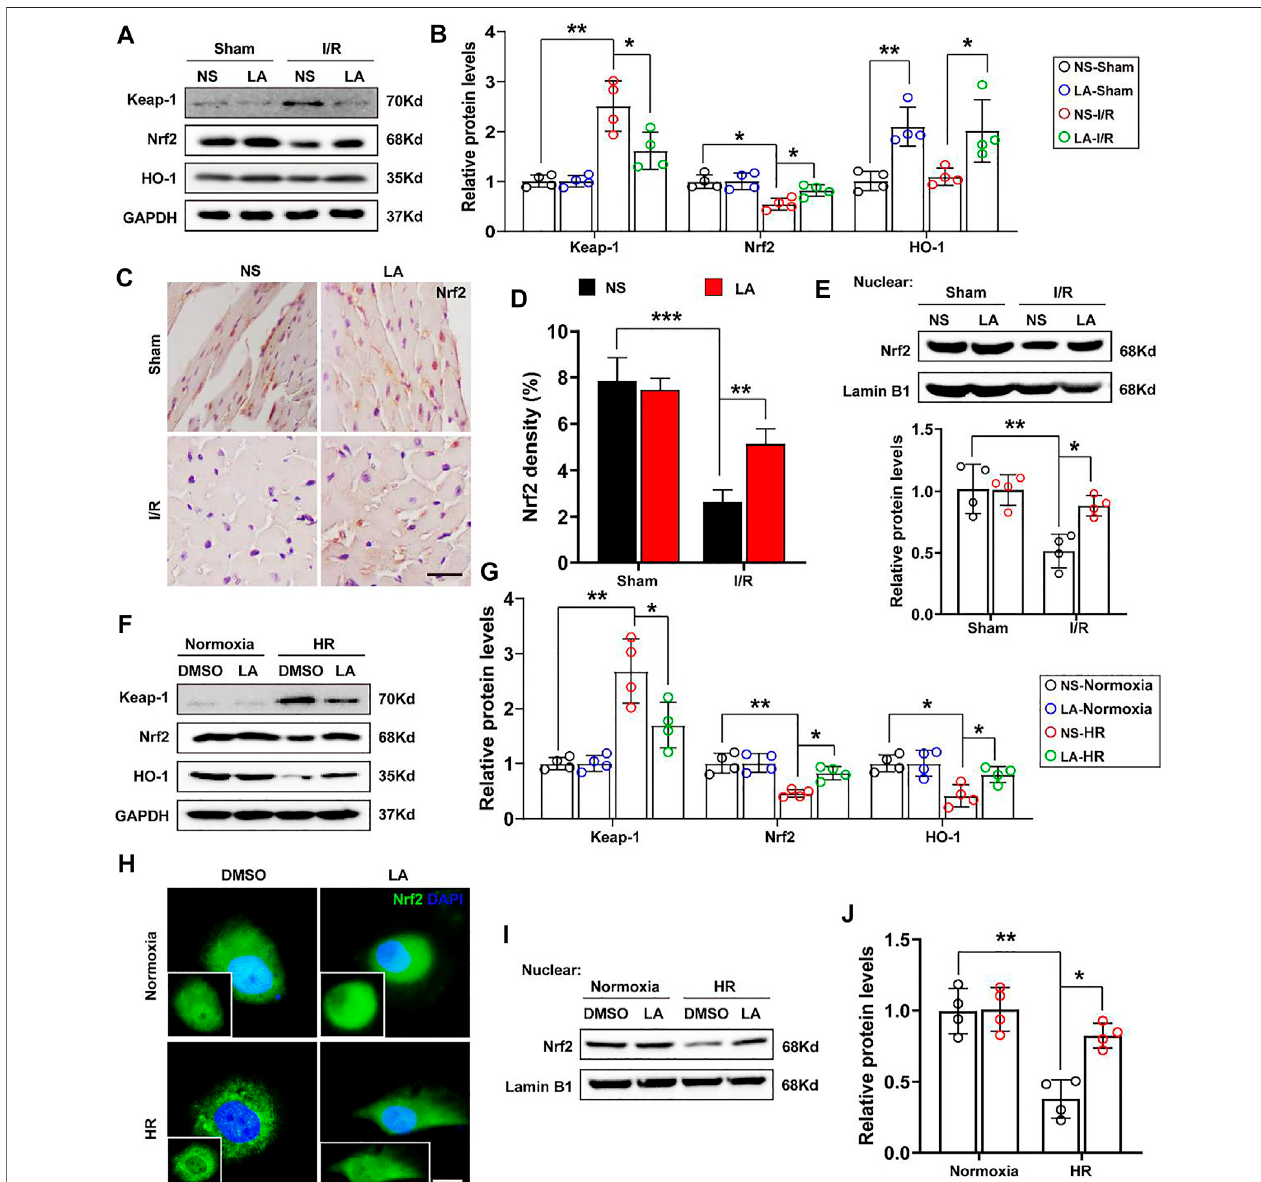
FIGURE6| LAcontributes toactivationofNrf2/HO-1pathway andnucleartranslocation ofNrf2 invivo and invitro (A,B) .Representative westernblot and analysis of Keap-1, Nrf2 and HO-1 in hearts following MI/R or sham, normalized to GAPDH ( n (cid:1) 4) (C,D) . Representative immunohistochemistry and density analysis of Nrf2 in heart tissues ( n > 25 from 3 mice per group). Scar bar: 100 μ m (E) . Representative western blot and analysis of Nrf2 in nuclear from fresh heart tissues, normalized to Lamin B1 ( n (cid:1) 4) (F,G) . Representative western blot and analysis of Keap-1, Nrf2 and HO-1 in H9C2 cells, normalized to GAPDH ( n (cid:1) 4) (H) . Representative immuno fl uorescence ofNrf2 inLA or DMSO pretreated H9C2 cells withor without HR. Scarbar: 10 μ m (I,J) . Representative western blotand analysisofNrf2 innuclear from H9C2 cells, normalized to Lamin B1 ( n (cid:1) 4). Data are presented as the mean ± SEM, with each point representing a mouse or a cell sample. * indicates p < 0.05, ** indicates p < 0.01, *** indicates p <